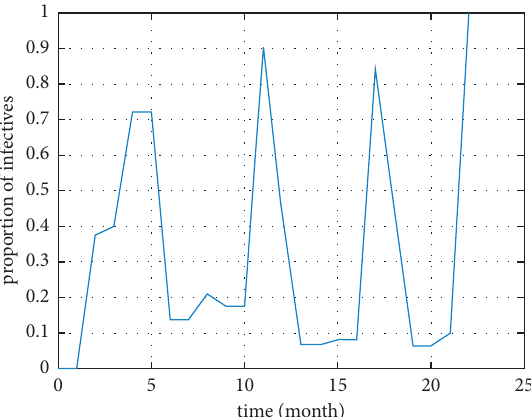
Figure 11: Te proportion of infective curves from smoothing by bin boundaries data and the model.